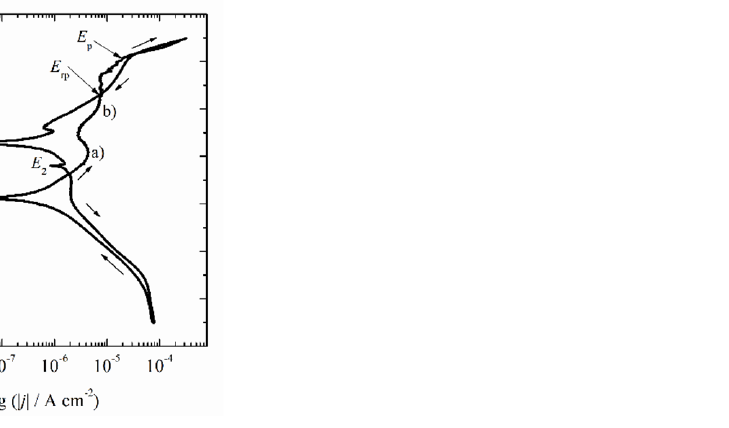
Figure 5. Initial polarization curve ( v = 1 mV s − 1 ) of the AuCuZnGe alloy after 1 h of immersion in 0.9 wt.% NaCl.